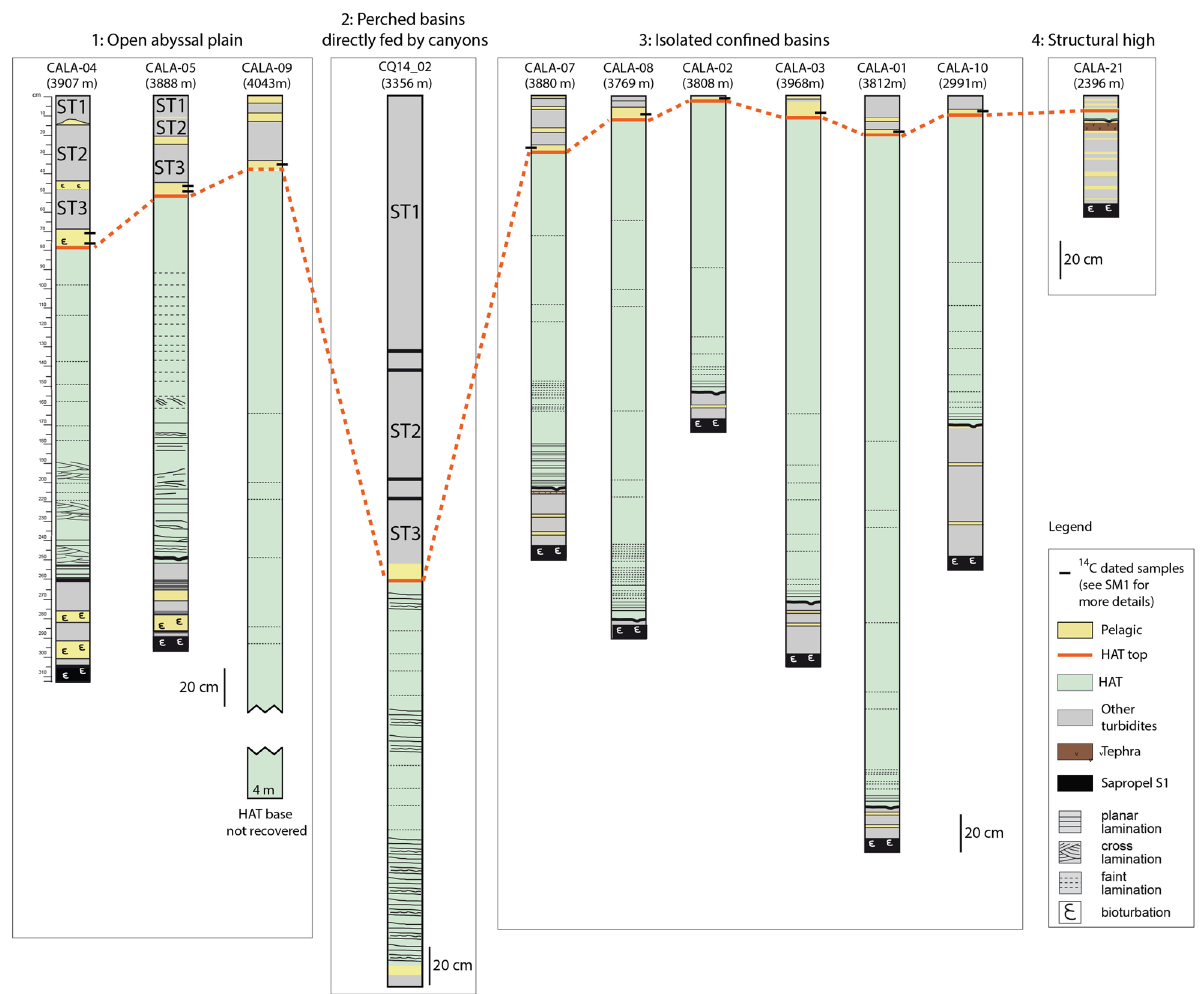
Figure 7. Correlation of the HAT thickness in gravity cores collected in different depositional settings. Open abyssal plain: CALA-04, CALA-05 and CALA-09. Perched basin directly fed by canyons from the Messina Straits region: CQ14_02. Isolated confined basins not connects to canyon systems: CALA-01, -02, -03, -07, -08, -10. Structural high: CALA-21 (Fig. 1 for core location). During the last 2000 yrs more than 90% of sedimentation in these cores is represented by seismically-triggered re-sedimented beds (green and grey units) while pelagic units (yellow) are thin layers bracketing turbidite beds. Pelagic sediment deposited after the 365 CE event were radiometrically dated (black rectangles) and radiometric dating results are discussed in Fig. SM1. The red line represents the top of the Homogenite/Augias Turbidite (HAT), which was emplaced after the CE 365 earthquake and tsunami 21